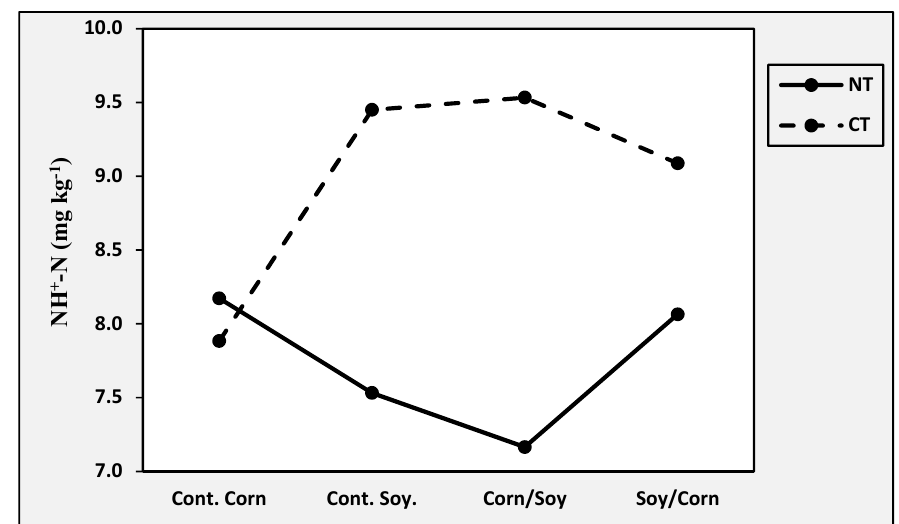
Figure 2. Effects of crop rotation x tillage interaction on NH 4 -N in 2013. Please note that NT = no tillage; CT = conventional (moldboard plow).